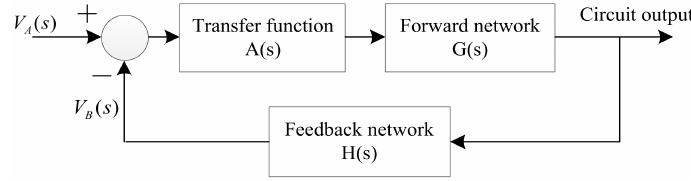
Figure 4. The control block diagram of the analog circuit.